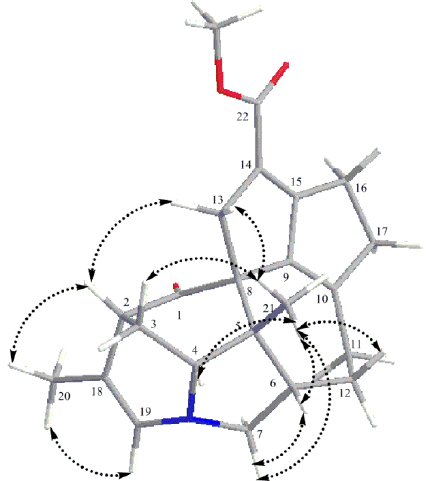
Figure 5. Key NOESY correlations of calyciphylline Q ( 3